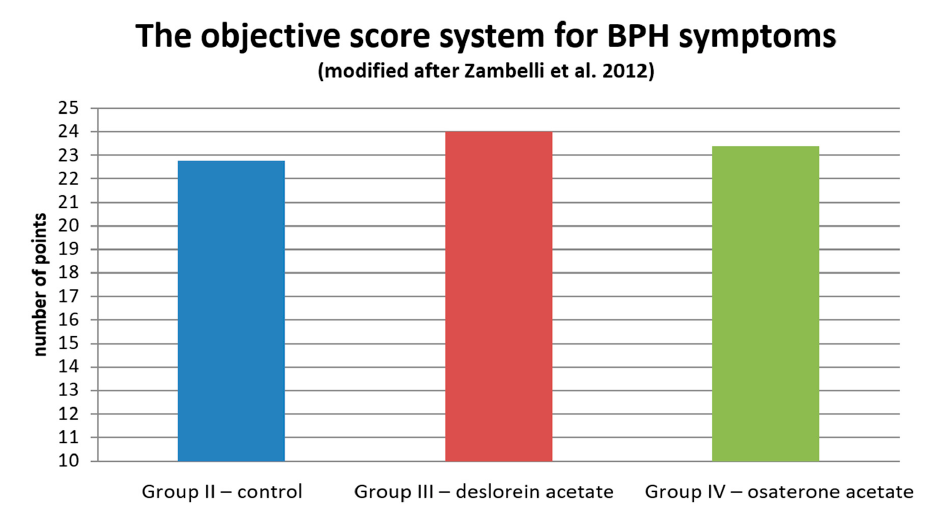
Figure 3. The severity and duration of BPH symptoms assessed using the objective scoring system modified after Zambelli et al. [20], on Day 0 before any treatment.